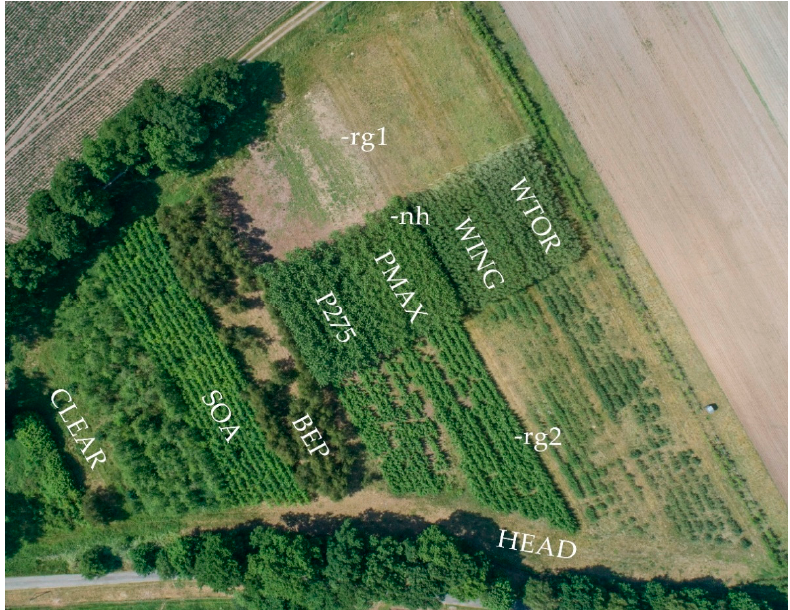
Figure 1. Aerial view on one of the three surveyed experimental SRC sites (site no. 3). The stands with different varieties of poplar and willow (in different growth-stages) and with different